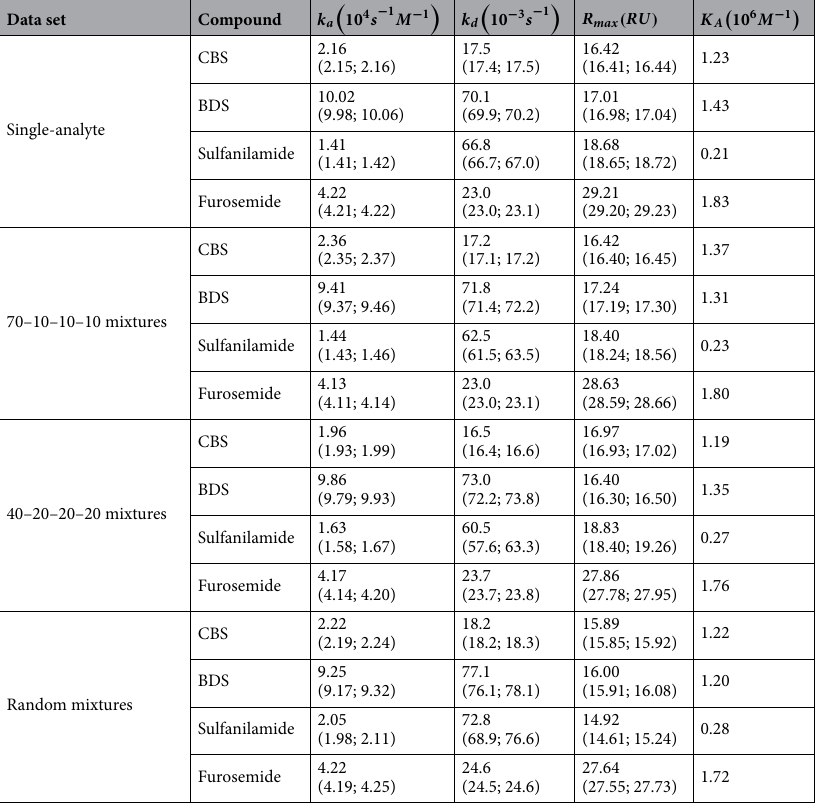
Table 2. Kinetic parameters identified from single- and multiple-analyte injections of mixtures of known composition. 95% confidence interval are given in parentheses. The estimated affinity ( K A ) is also